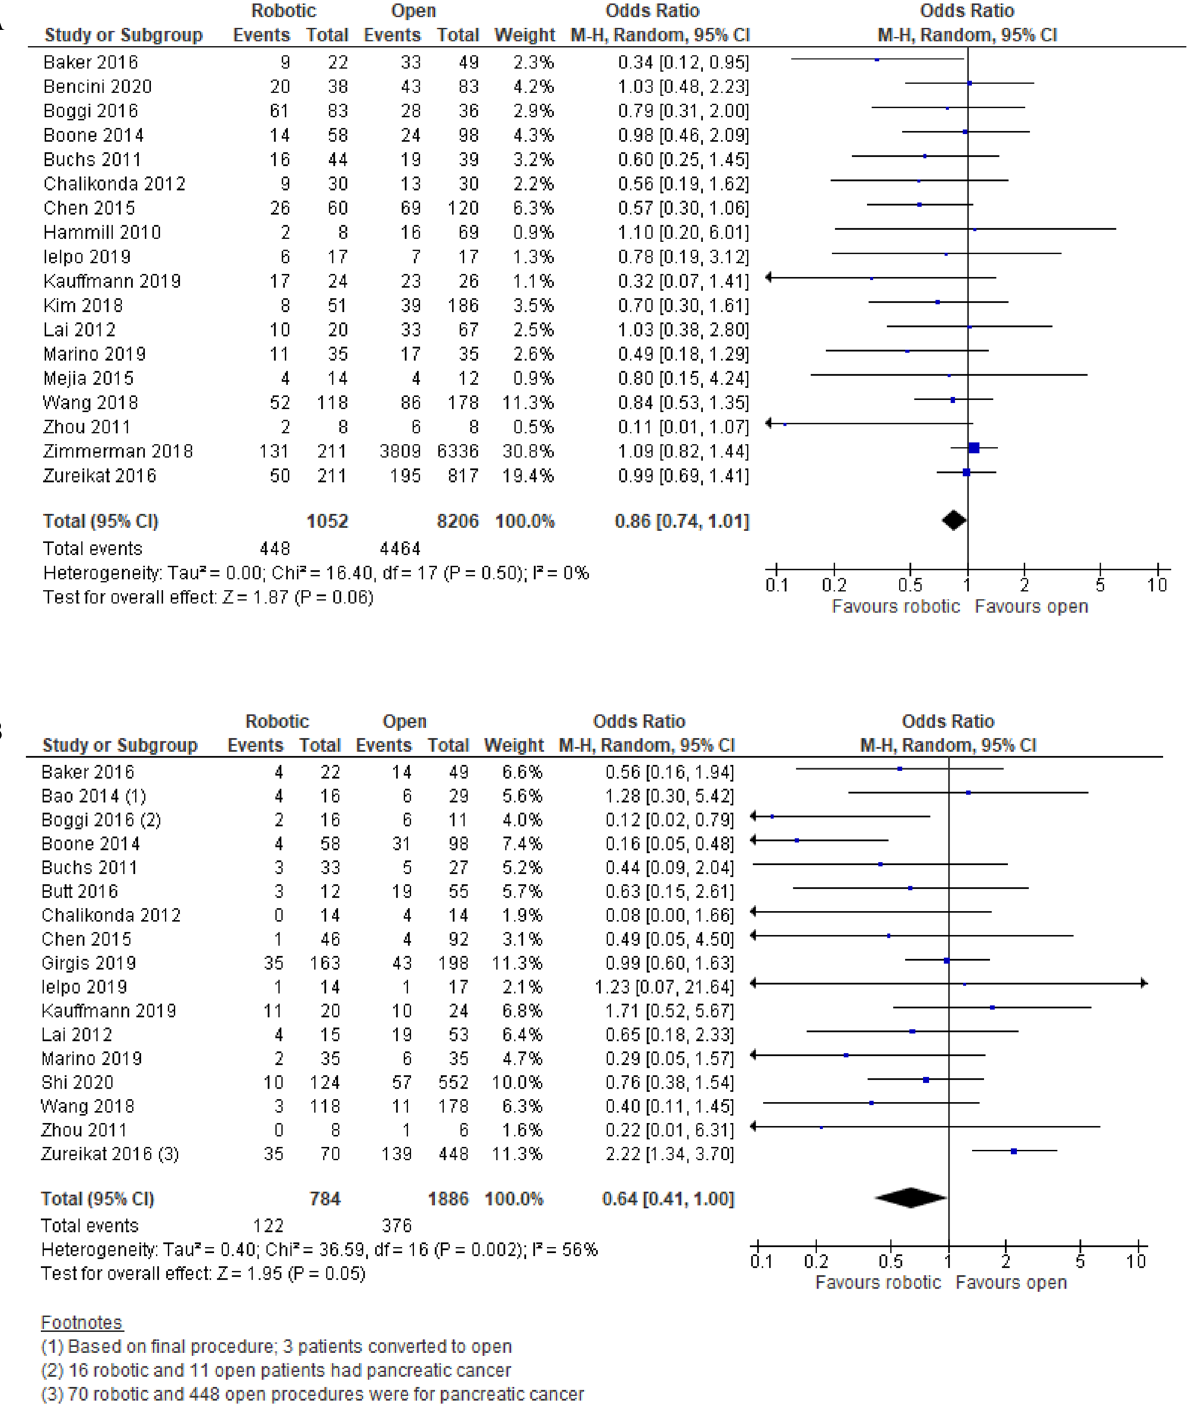
Figure 4. Meta-analysis of primary endpoints: ( A ) Overall postoperative morbidity. ( B ) Resection margin involvement